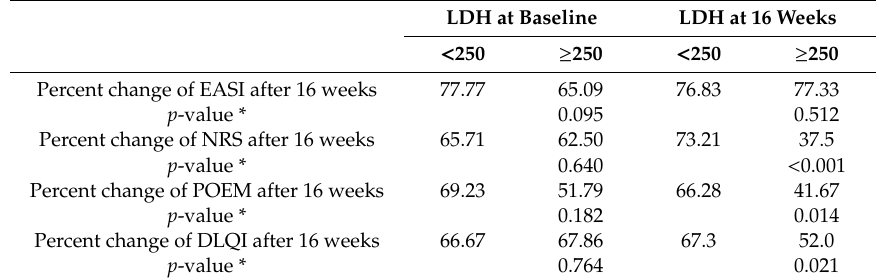
Table 5. The di ff erence of e ffi cacy, according to LDH. Elevated LDH at 16 weeks showed inadequate treatment response in NRS, POEM, and DLQI.